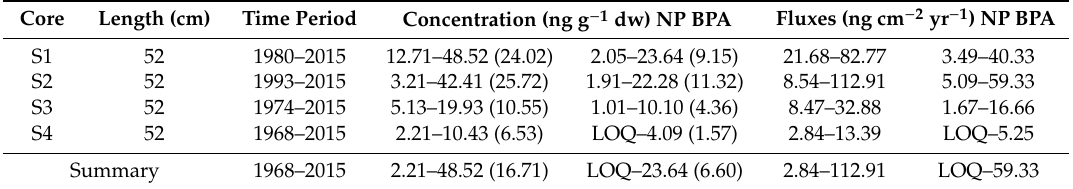
Table 2. Concentrations and fluxes of NP and BPA and time periods at sampling